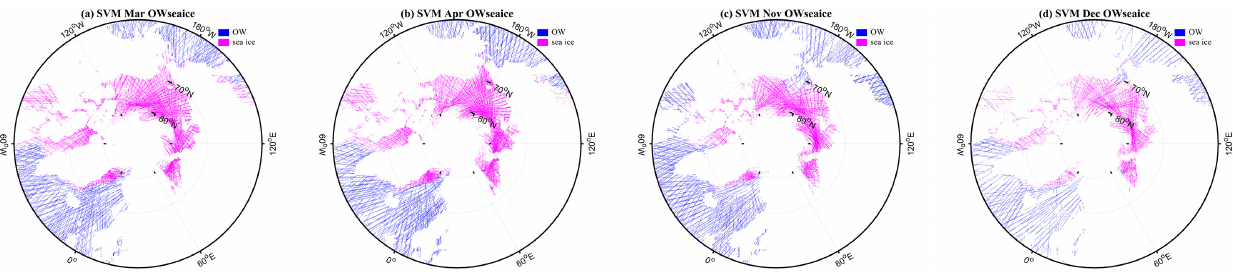
March, ( c ) April, and ( d ) November are used as the test set in turn.